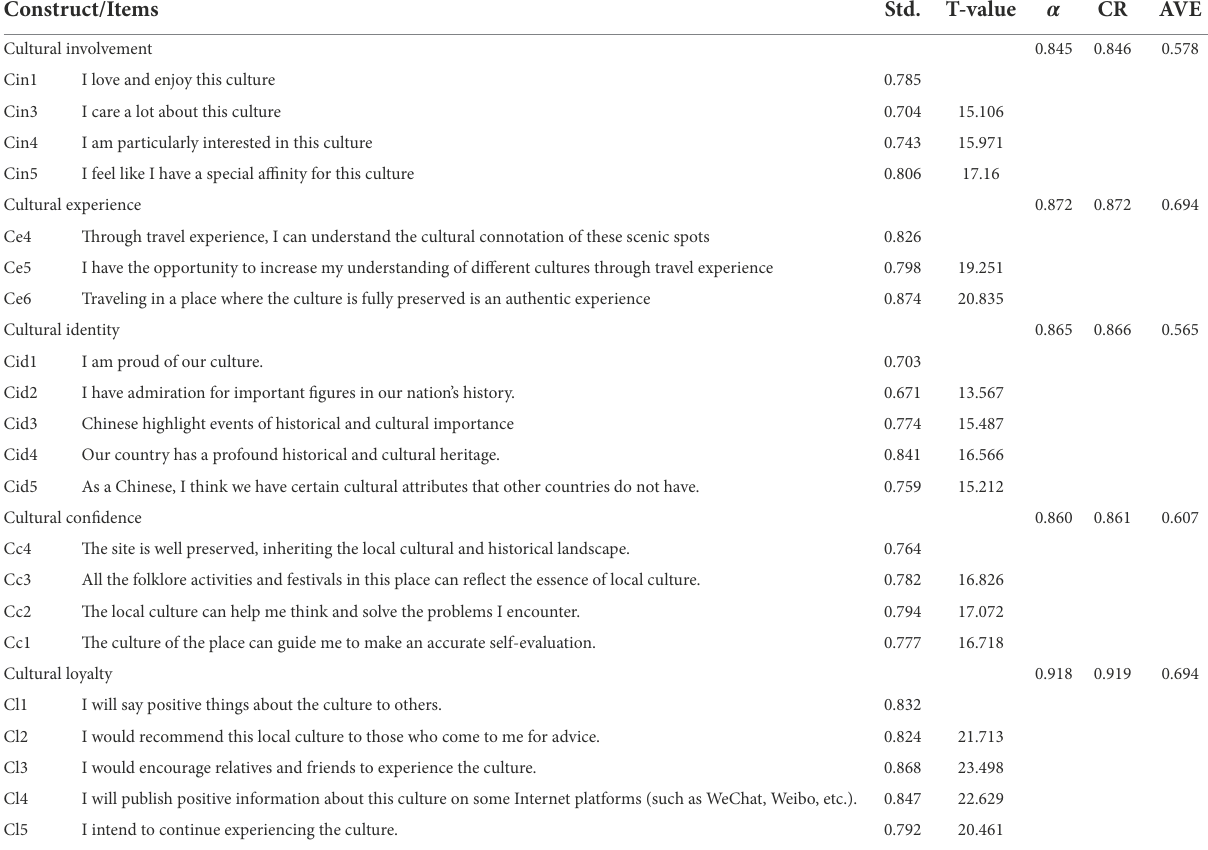
TABLE 1 The results of confirmatory factor analysis ( n =